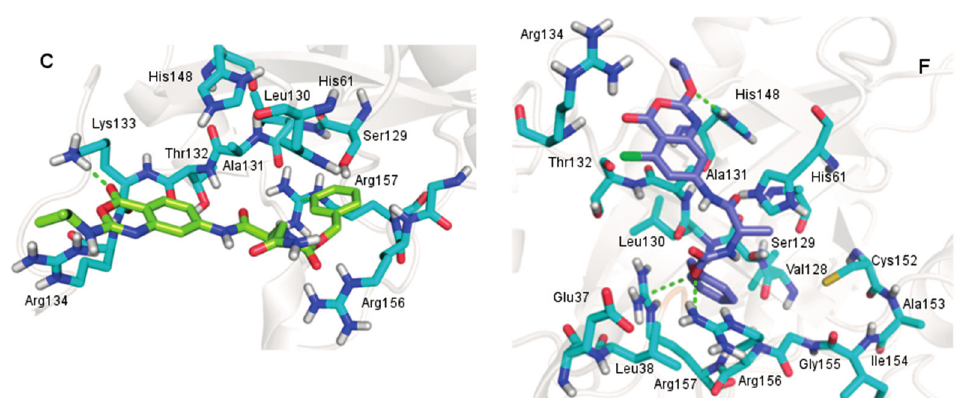
Figure 5. Representation of the molecular docking results between HSV-1 protease (blue) and aminobenzoxazinones 2 ( A ); 4 ( B ) and 5 ( C ) and oxybenzoxazinones 11 ( D ); 14 ( E ) and 13 ( F ). The comparison showed bulky substituents affecting the ligands positioning at binding site. Hydrogen bonds and cation- π interactions are indicated in green.